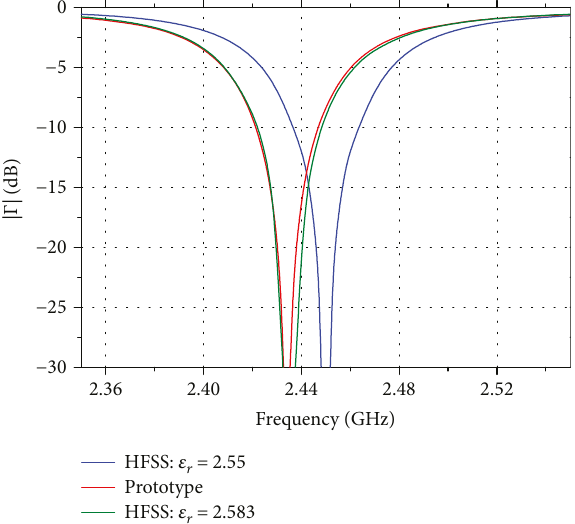
Figure 23: Input impedance of the conventional microstrip antenna.